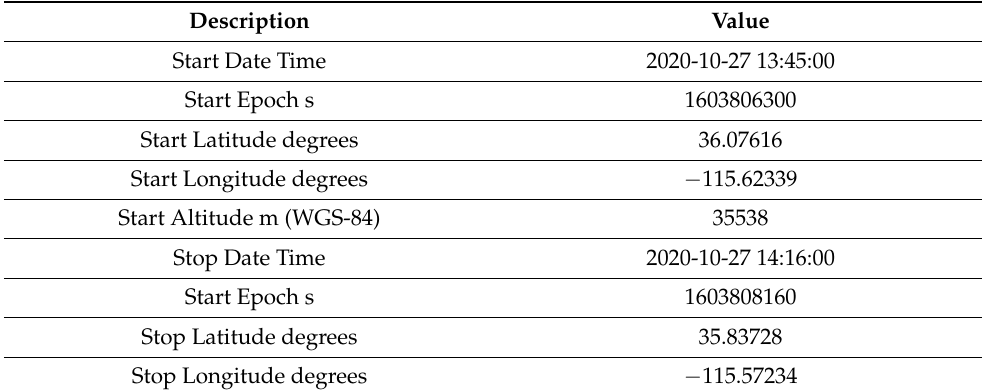
Table 1. Bounder Event